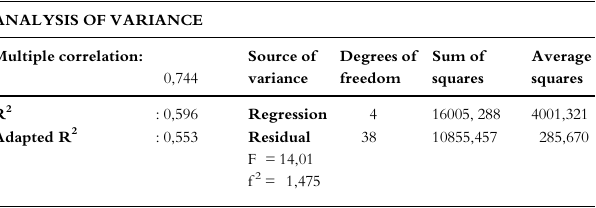
TABLE 3 REGRESSIONANALYSISOF SENSEOFCOHERENCE, JOBSATISFACTIONAND SUICIDE IDEATION IN THEWHITEGROUP ANALYSIS OF